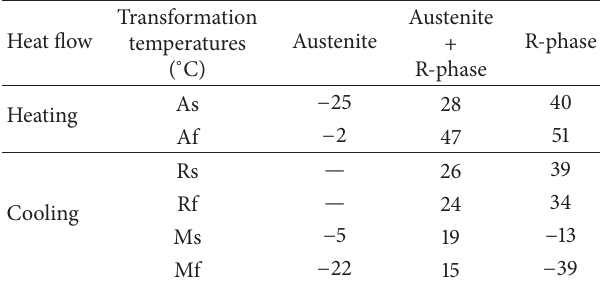
Table 1: Transformation temperatures measured by